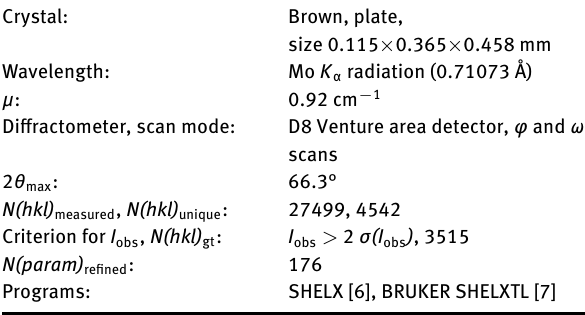
Table 2: Fractional atomic coordinates and isotropic or